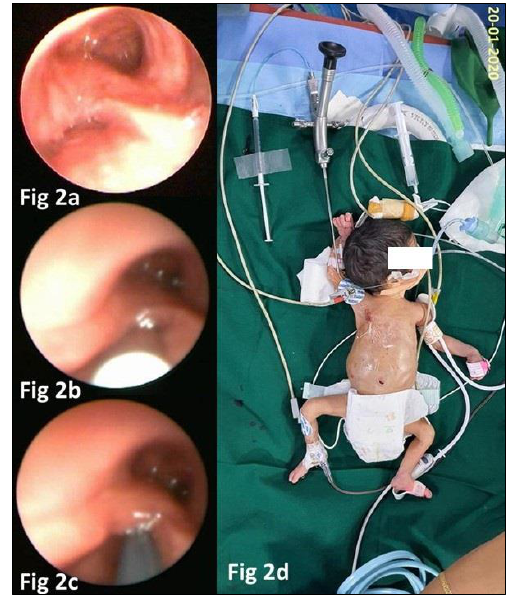
Fig.2a. LTS showing wide fistula opening with irregular edges show- ing trauma, Fig.2b. Fogarty catheter tip is being negotiated into the fistula and Fig.2c. Well placed Fogarty catheter through the fistu- la.Fig.2d. Cystoscope with offset lens used for LTS and the Fogarty catheter stent passed through the fistula into the stomach.